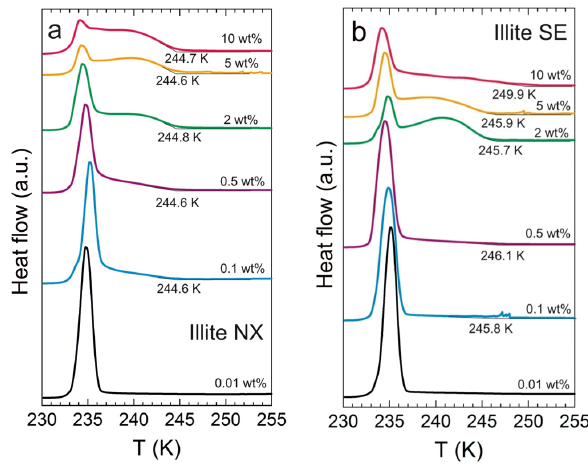
Fig. 4. DSC thermograms of Ill NX (panel a ) and Ill SE (panel b ). Curves are shown with different offsets for clarity. Suspension concentrations and onsets of heterogeneous freezing are indicated above and below the curves, respectively. The onset of the freezing peaks ( T on ) is given by the intersection of the two tangent lines (thin black curves) for each curve.